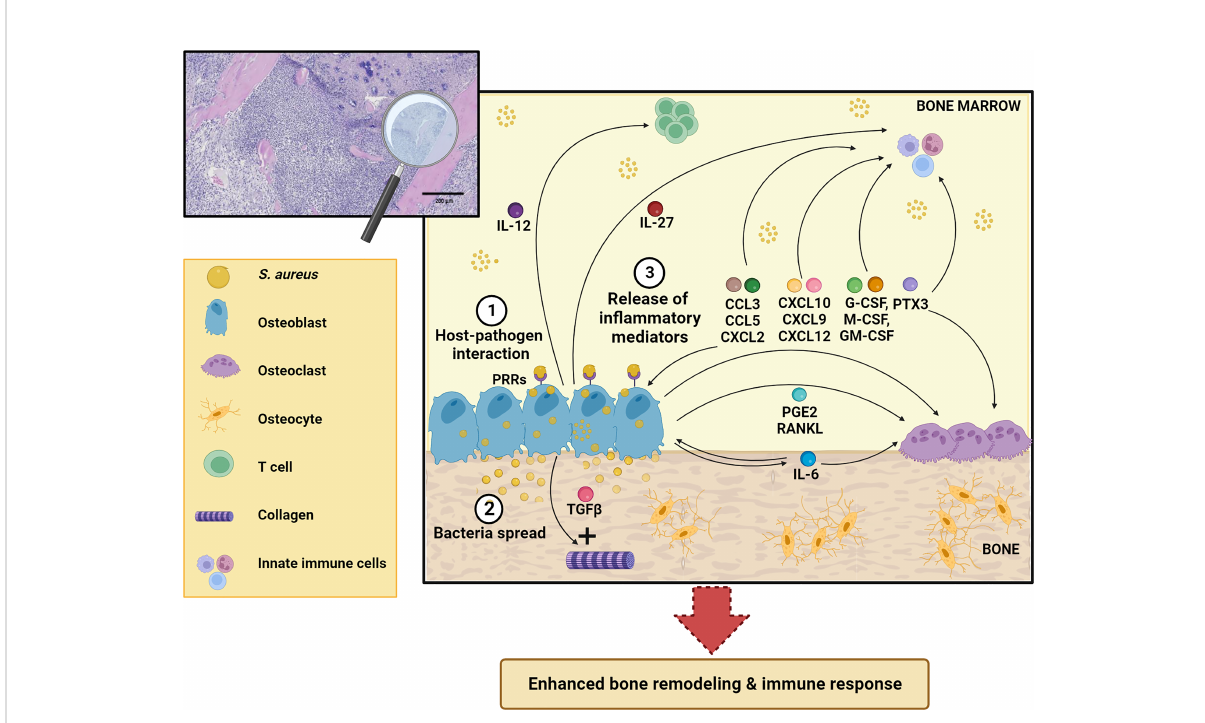
FIGURE 2 Schematic representation of osteoblast response to S. aureus infection. After osteoblast infection (1), S. aureus can grow and spread further in the bone (2) and induce synthesis and release of different in fl ammatory mediators (IL-12, IL-27, IL-6, CCL3, CCL5, CXCL2, CXCL10, CXCL9, CXCL12, TGF b , G-CSF, M-CSF, GM-CSF, PTX3, RANKL, PGE 2 ) (3) that act both on skeletal and immune cells. This leads to enhanced bone remodeling and immune response. See the main text for more details. The Figure was created with